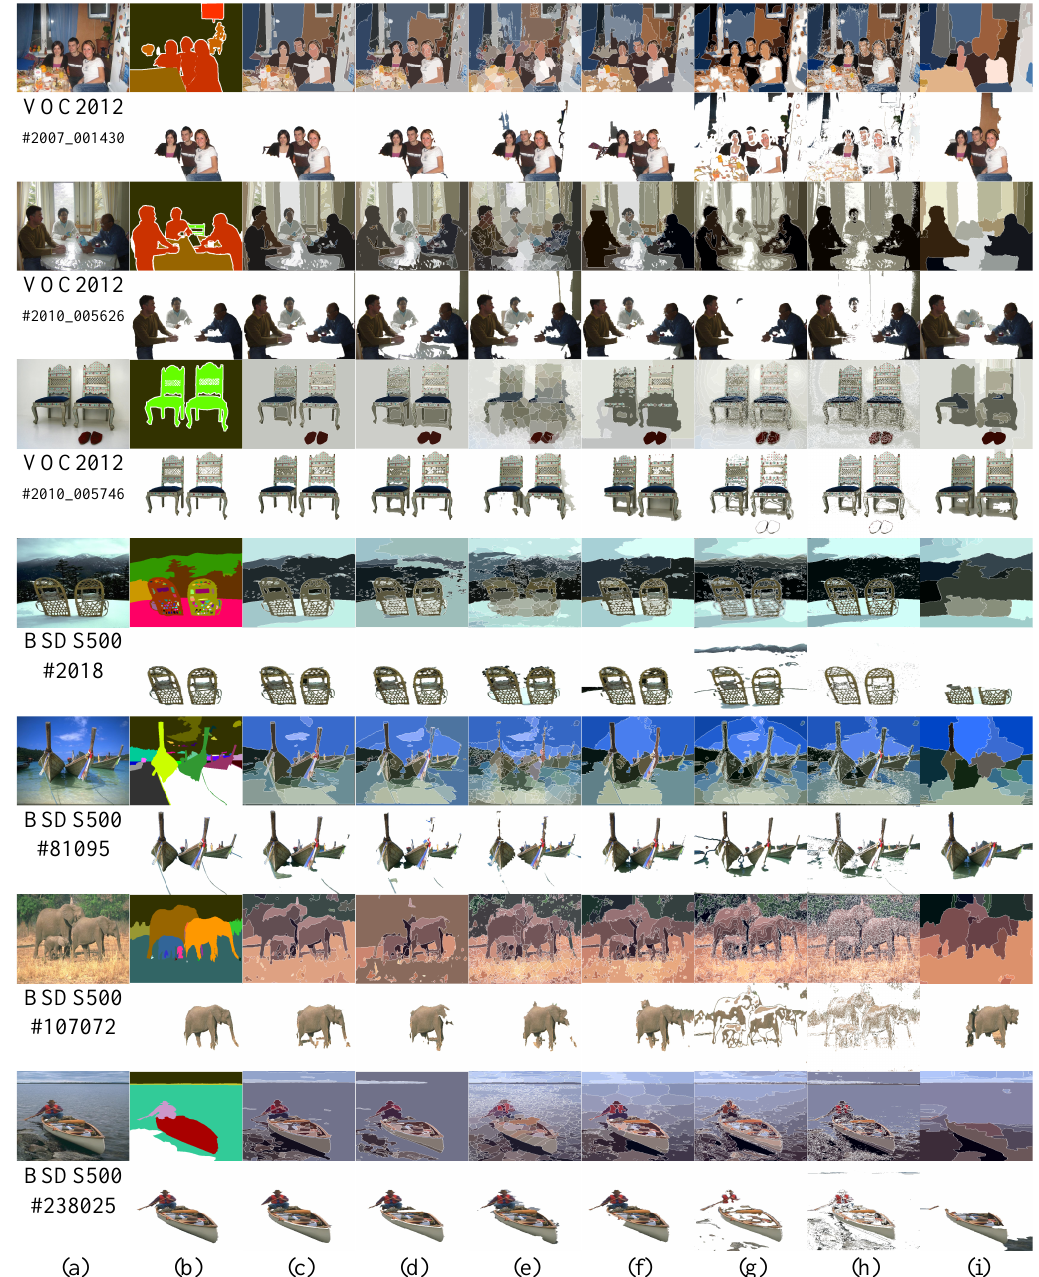
Figure 11. Color image segmentation results. ( a ) dataset images, ( b ) ground truths; results of ( c ) PMLCD, ( d ) PMVIF, ( e ) watershed, ( f ) SLIC, ( g ) K-means, ( h ) mean shift, and ( i )